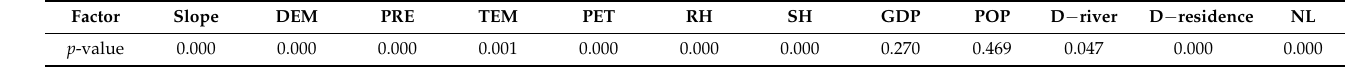
Table 3. The p -value of related